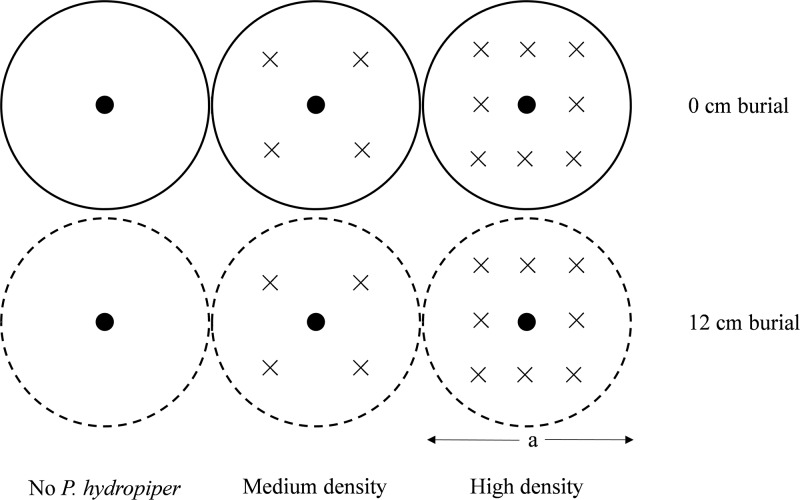
Diagram of the experiment design. “×” means neighbor plants and “●” means target plants.a = 16 cm.